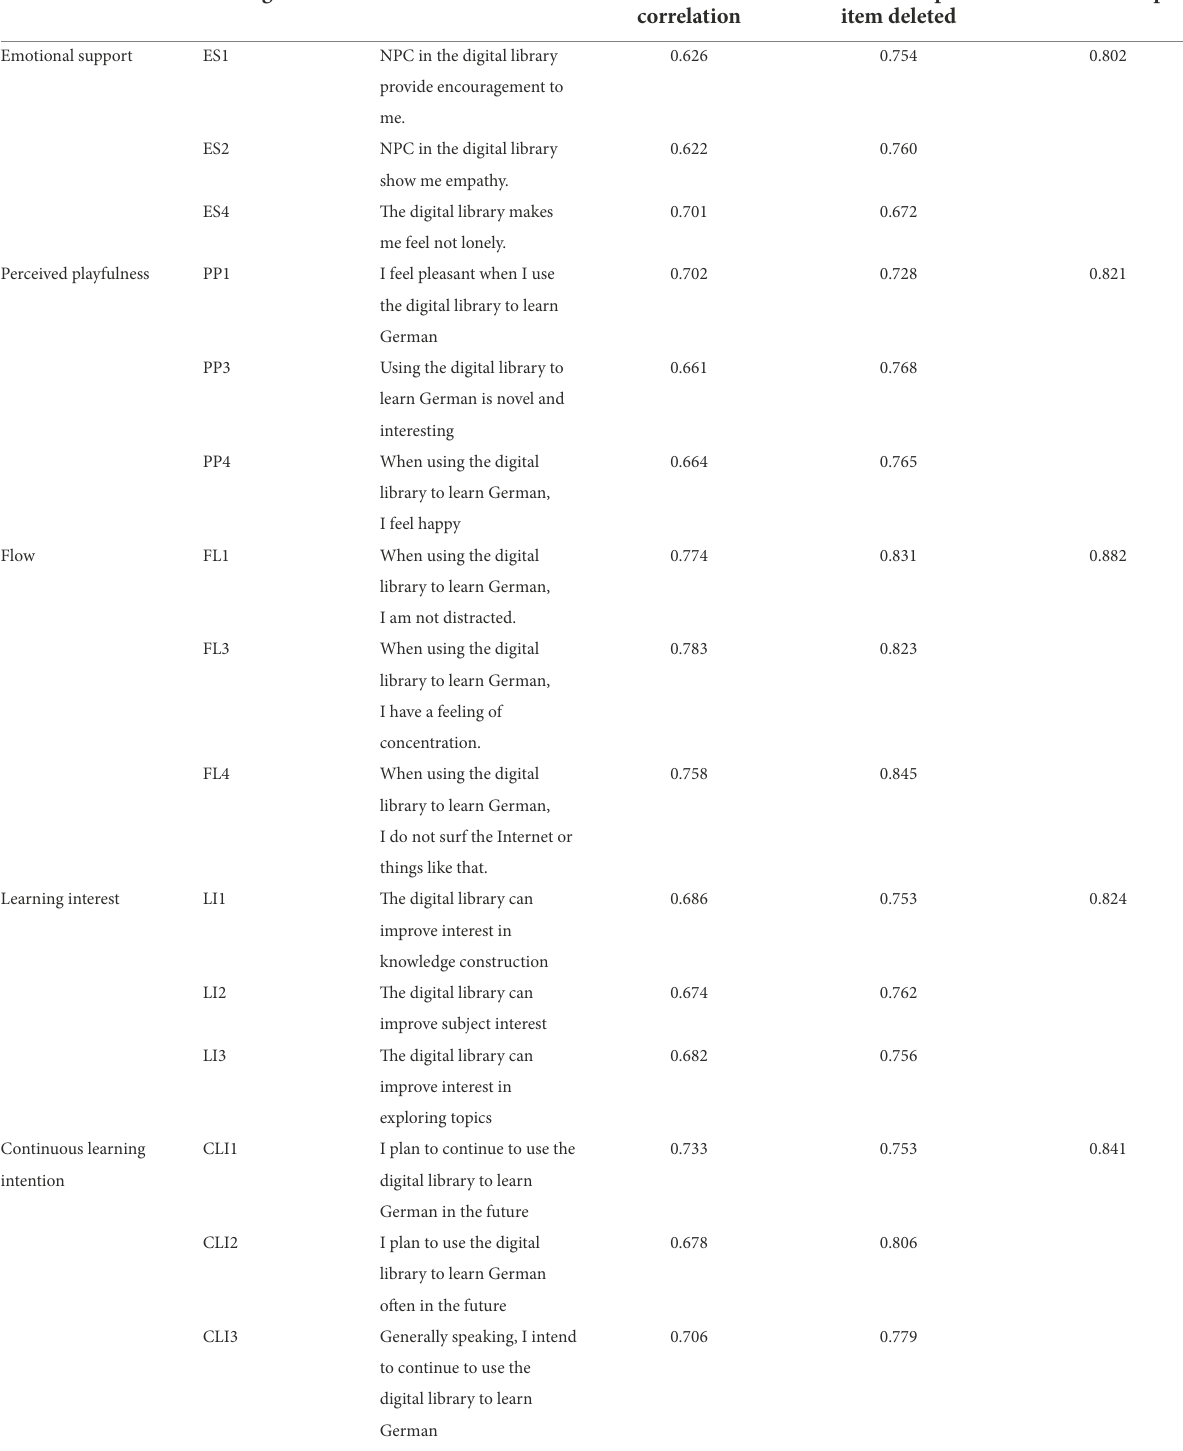
TABLE 2 Description of the test